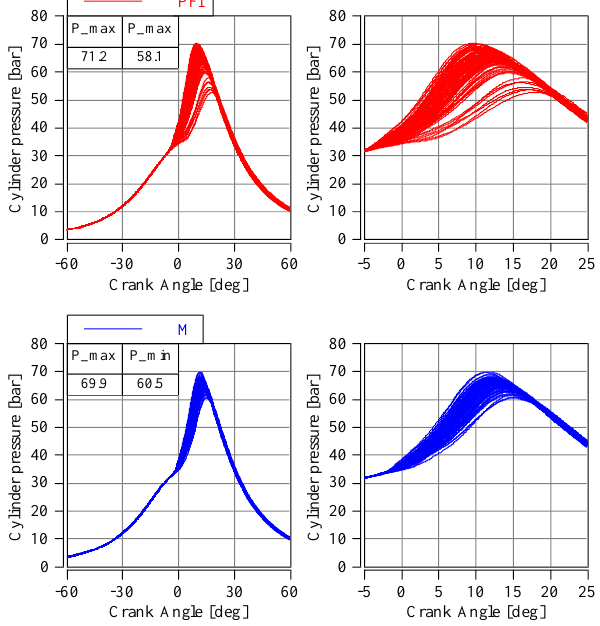
Fig. 5. Dispersion of in cylinder pressure trace for equivalence ratio λ = 1.55, PFI marked in red, mixer system in blue